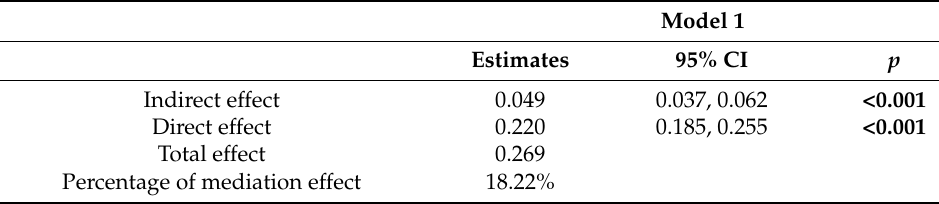
Table 5. Bootstrap mediation analysis of the role of personal